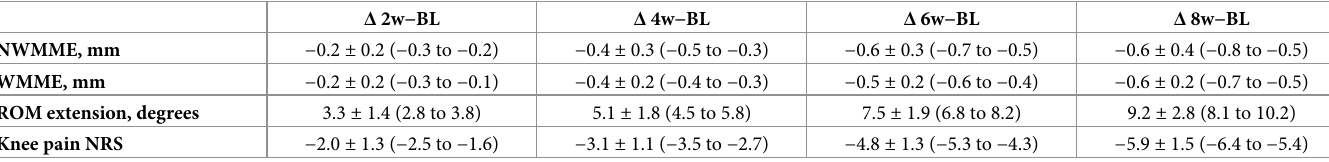
Table 3. Amount of change in each parameter from